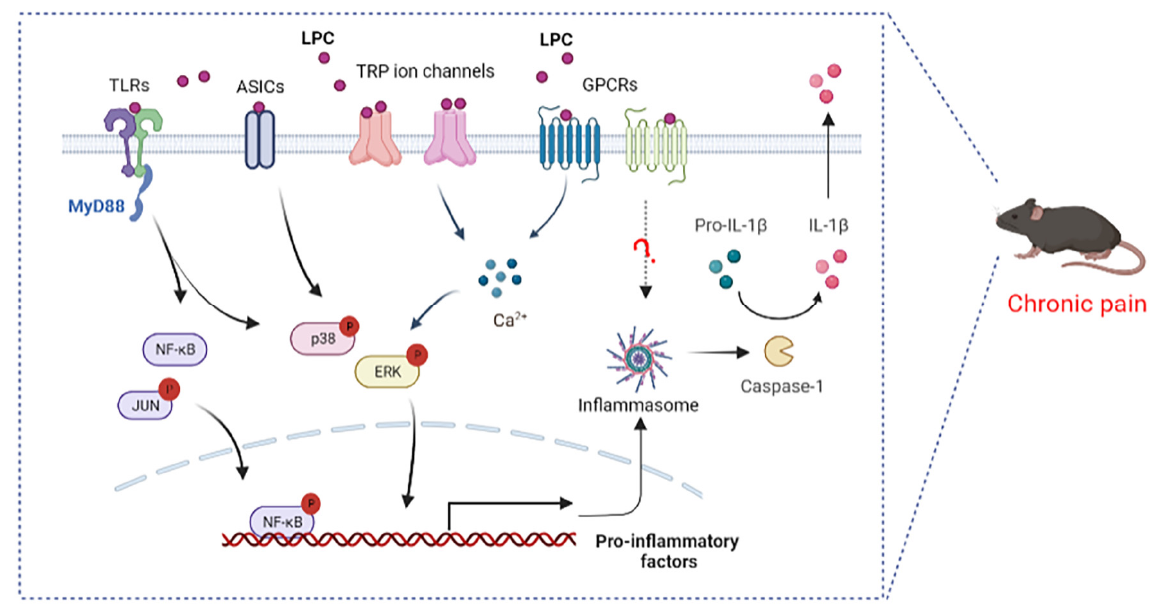
Figure 4. Proposed signaling pathways by which LPC mediates pain. LPC, lysophosphatidylcholine; TLRs, Toll-like receptors; GPCRs, G protein–coupled receptors; ASICs, acid-sensing ion channels; TRP, transient receptor potential; MyD88, myeloid differentiation factor; NF- κ B, nuclear factor kappa-B; ERK, extracellular-signal-regulated kinase; Caspase-1, cysteinyl aspartate specific proteinase-1; IL-1 β , interleukin-1 beta.